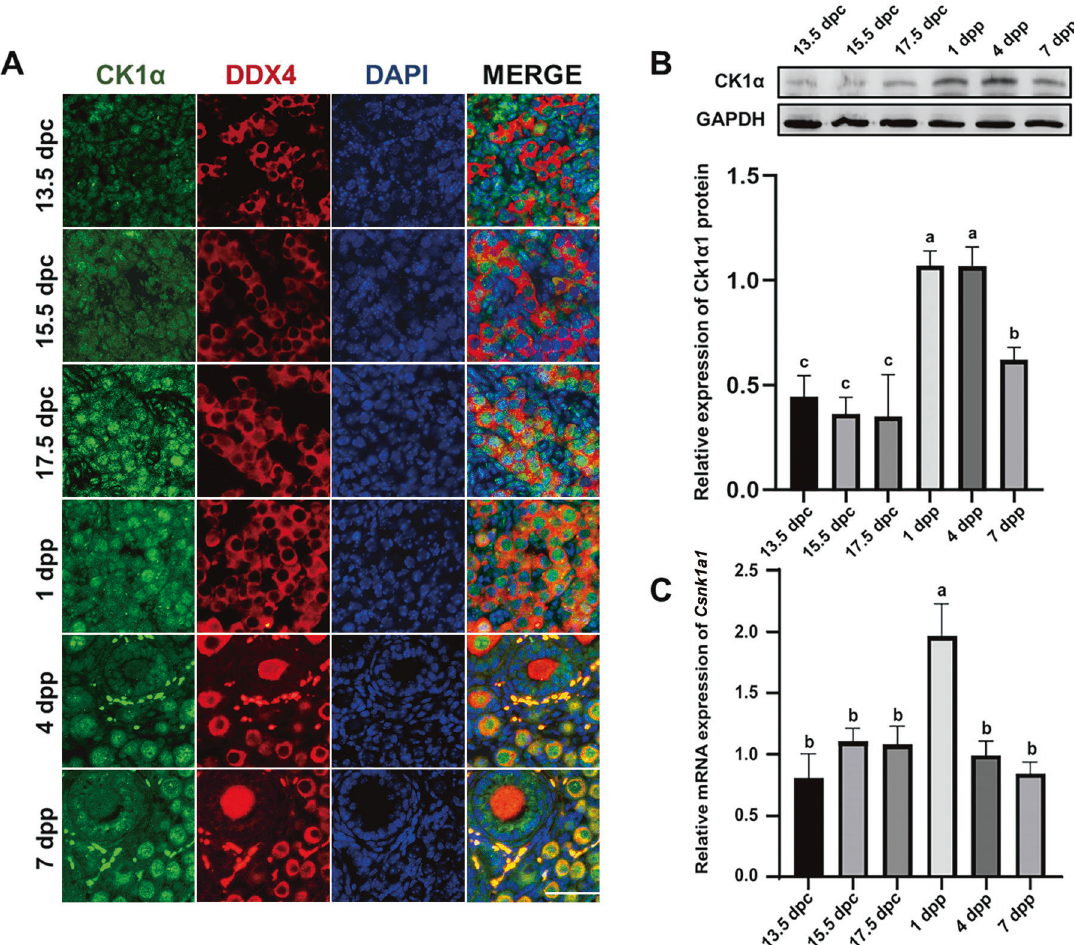
Fig. 1 CK1 α expression in the developing mouse ovary from 13.5 to 7 dpp. A CK1 α (green) and DDX4 (oocyte marker, red) dual immuno fl uorescence in ovaries. Scale bar: 50 μ m. B , C CK1 α mRNA and protein levels in different stages of mouse ovaries assayed by RT-qPCR and western blot, respectively. Relative mRNA and protein levels were normalized to GAPDH ( n = 4). dpc days post-coitum, dpp days post- partum. The same letters indicate the difference is not signi fi cant, and the different letters between two bars show a signi fi cant difference ( P < 0.05). The values are the means ± SEM; P- values were determined by one-way analysis of variance (ANOVA) with Duncan ’ s multiple comparisons